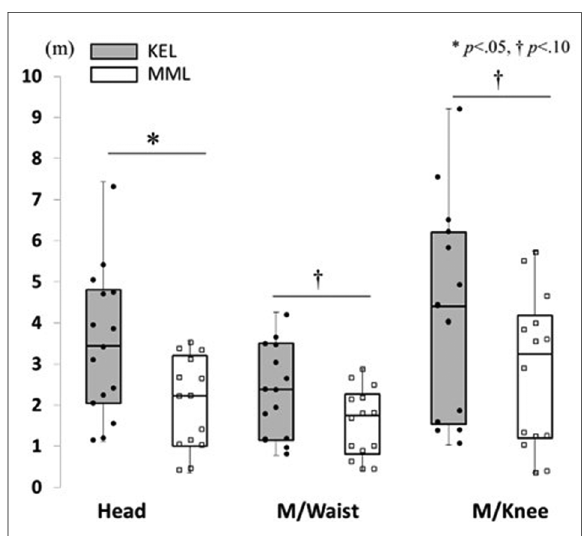
FIGURE 8 Difference in total trajectory length while maintaining balance